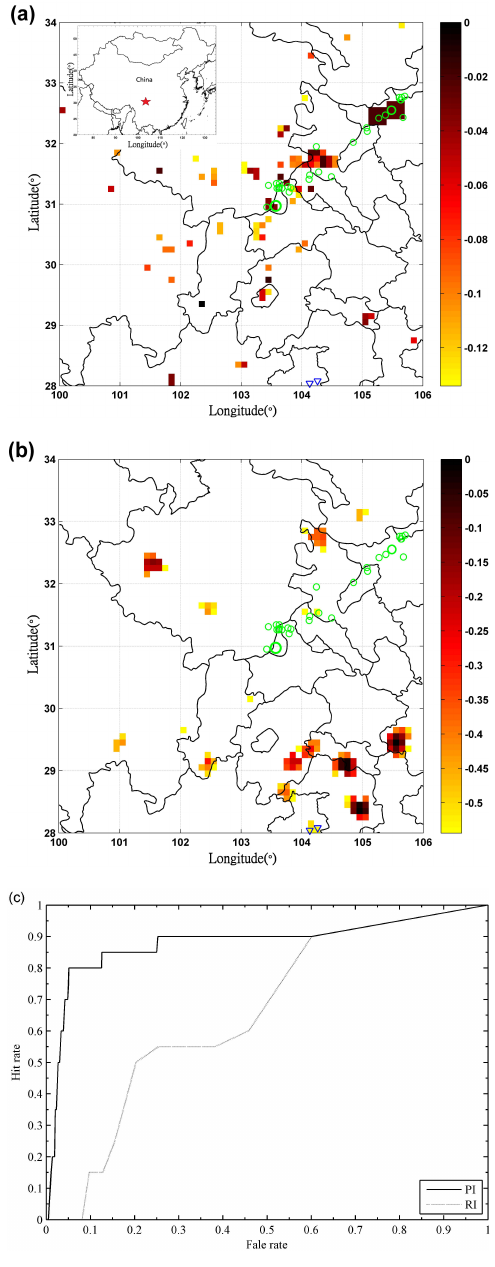
Fig. 2. (a) Pattern informatics (PI) map and (b) Relative intensity (RI) map. Blue inverted triangles indicate the earthquakes from 1 October 2001 ( T 1 ) to 31 January 2008 and green circles indicate the earthquakes from 1 February 2008 ( T 2 ) to 31 July 2008 ( T 3 ). The magnitude threshold of all displayed earthquakes was 5.0. The values of hotspots were normalized by the respective maximum in each figure and were displayed in logarithmic scales. Red star in the insert indicated the epicenter of the 2008 Wen-chuan, China earthquake. (c) Relative operating characteristic (ROC) diagram. ROC diagram evaluated the similarity of spatial distribution be- tween hotspots (in PI or RI map) and the Wen-chuan earthquake sequence. Through comparing areas under curves, the PI map per- formed better in this